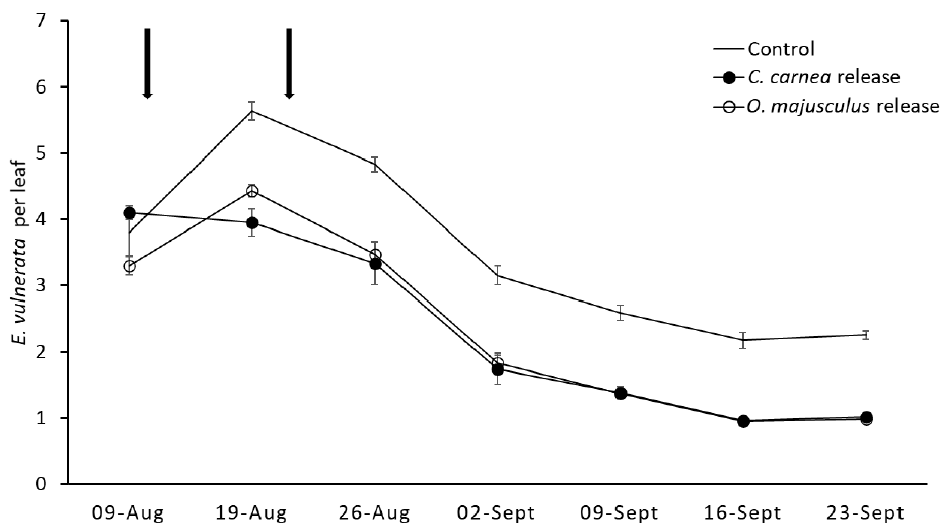
Figure 7. Erasmoneura vulnerata densities (mean ± SE) in vineyard plots characterized or not by pred- ator releases (experiment 2, 2019). Each arrow indicates predator release events. predator releases (experiment 2, 2019). Each arrow indicates predator release